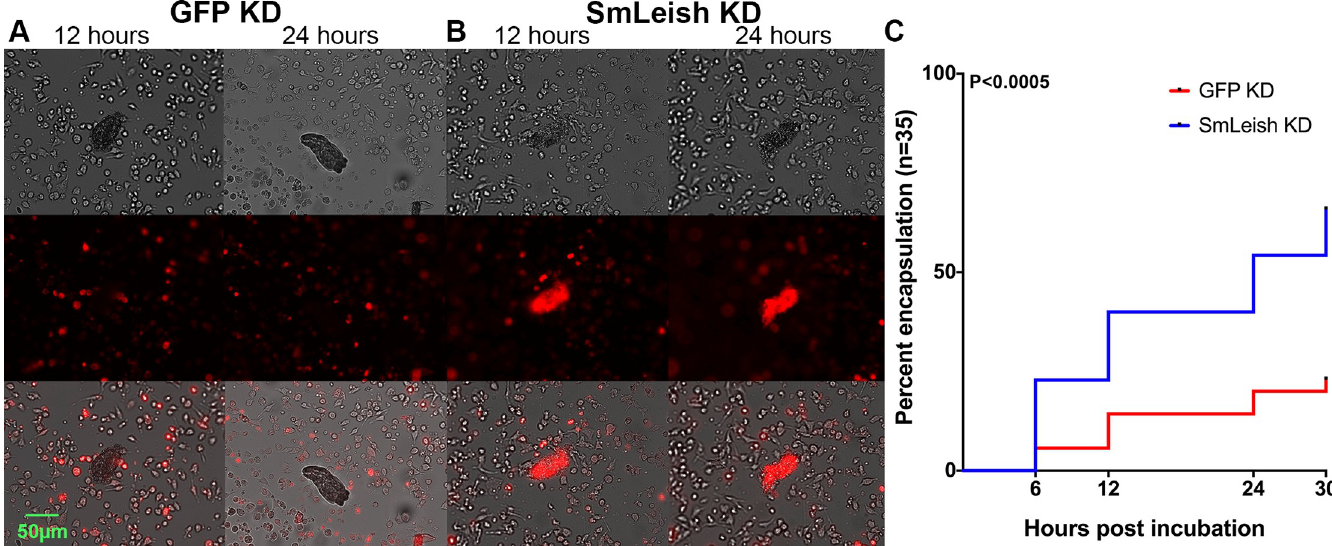
Fig 6. SmLeish impacts infection success by affecting the ability of haemocytes to encapsulate S . mansoni sporocysts. Encapsulation of S . mansoni sporocysts was visualized using fluorescently labelled M-line haemocytes and incubating them with GFP (A) or SmLeish (B) knockdown sporocysts that had been transformed in vitro . GFP knockdown control sporocysts in which SmLeish expression remains intact were infrequently encapsulated (A and C) compared to SmLeish-knockdown sporocysts, which were more frequently encapsulated by 24 hours post incubation (p < 0.0005) (B and C). Representative images of an encapsulated and non- encapsulated sporocyst at 12 and 24 hours post incubation are shown (A and B).